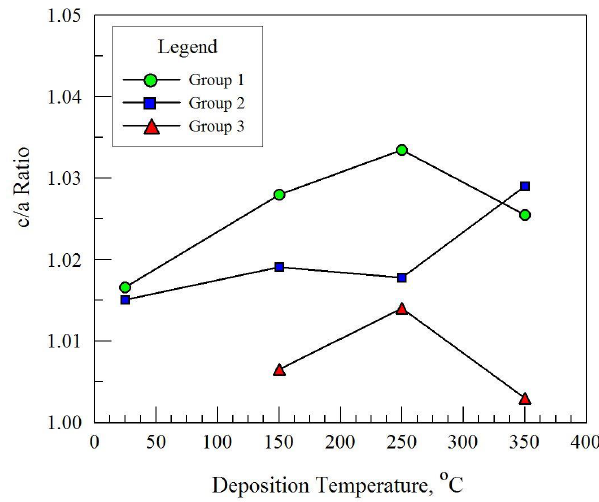
Figure 3. The calculated values of c / a based on Equation (2), using a 111 and a 200 values determined from the X-ray diffraction patterns, the c / a values decrease with increasing Ti (and N) concentrations, indicating a reduction in lattice distortion.